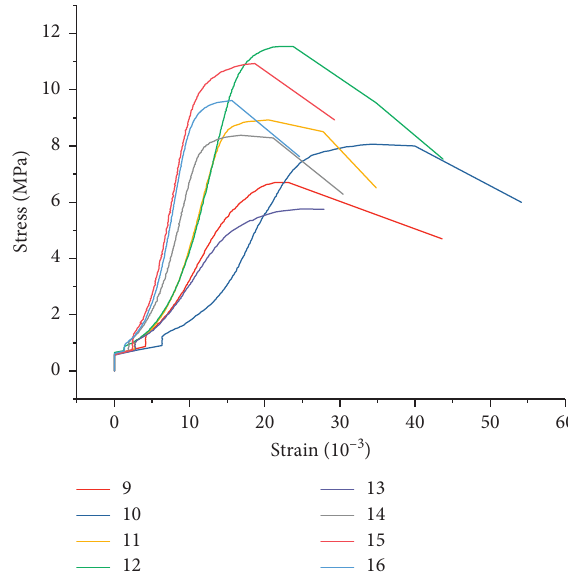
Figure 5: Stress-strain curve of